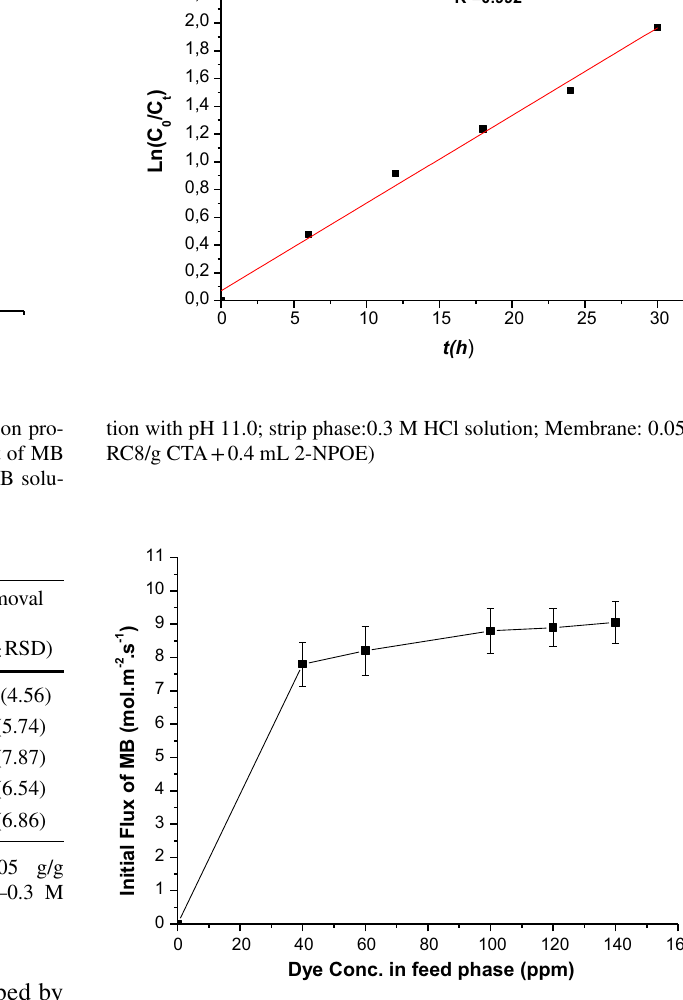
Fig. 9 Effect of dye concentration in feed phase. Feed phase: 40–140 mg/L at pH = 11, stripping phase: 0.3 M HCl, Transport time 30 h at 25